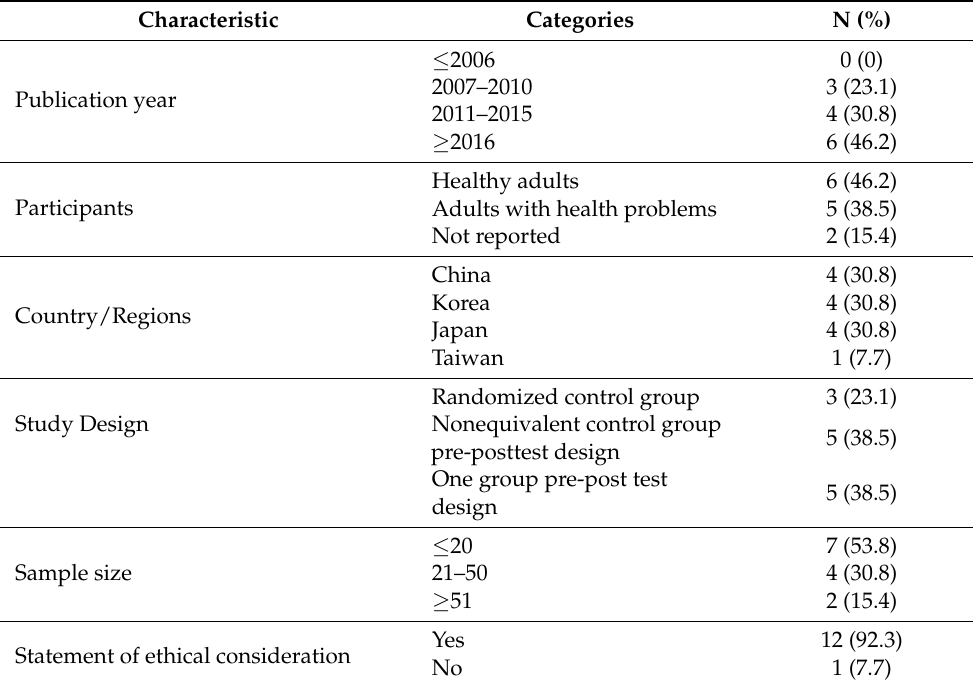
Table 1. General characteristics of included studies ( n =